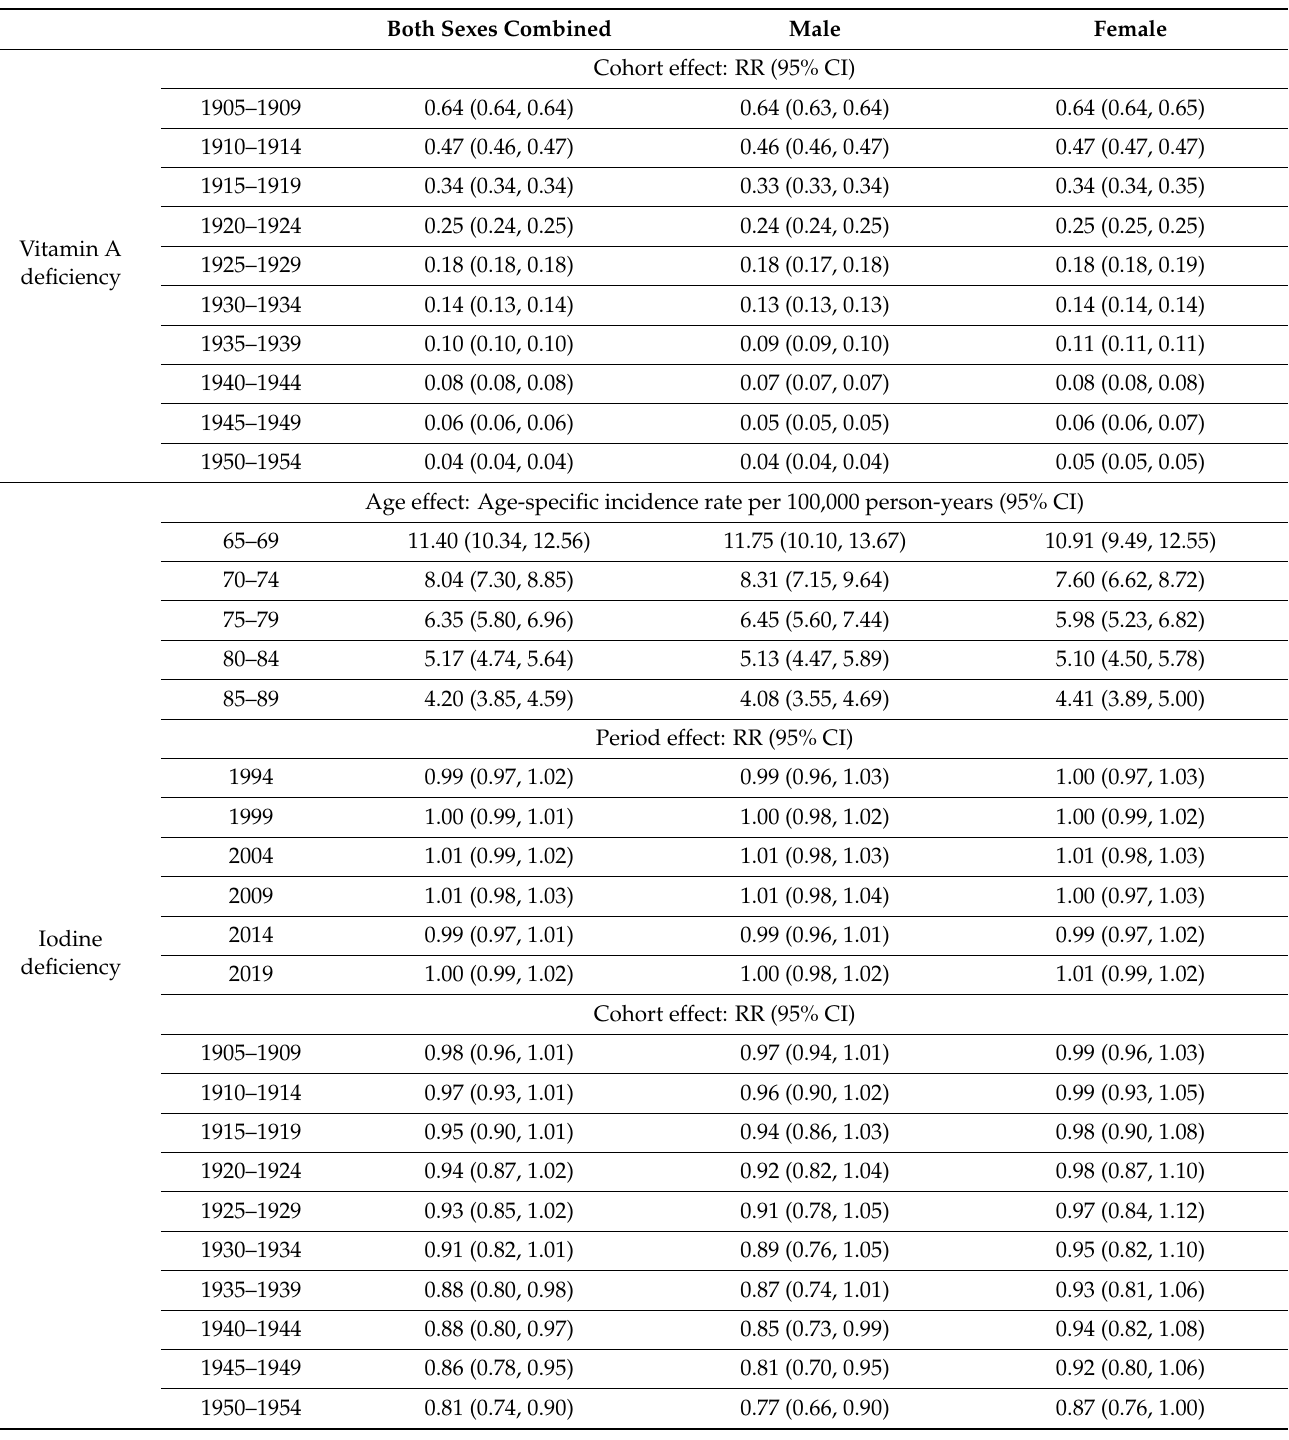
Table 1. Cont. Both Sexes Combined Male